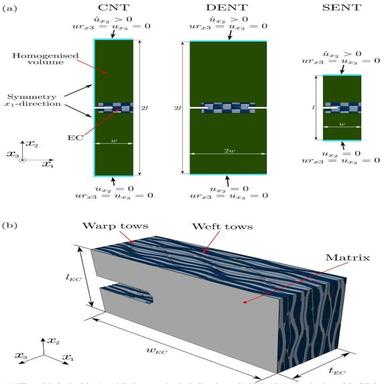
(a) FE models for 3 of the 4 modelled geometries, including the applied BCs; (b) isometric view of the EC for the SENT model, highlighting the randomly-stacked compacted woven plies. The ECs include matrix resin pockets between the tows, with the former not being shown in (a) for clarity purposes, but presented in (b).